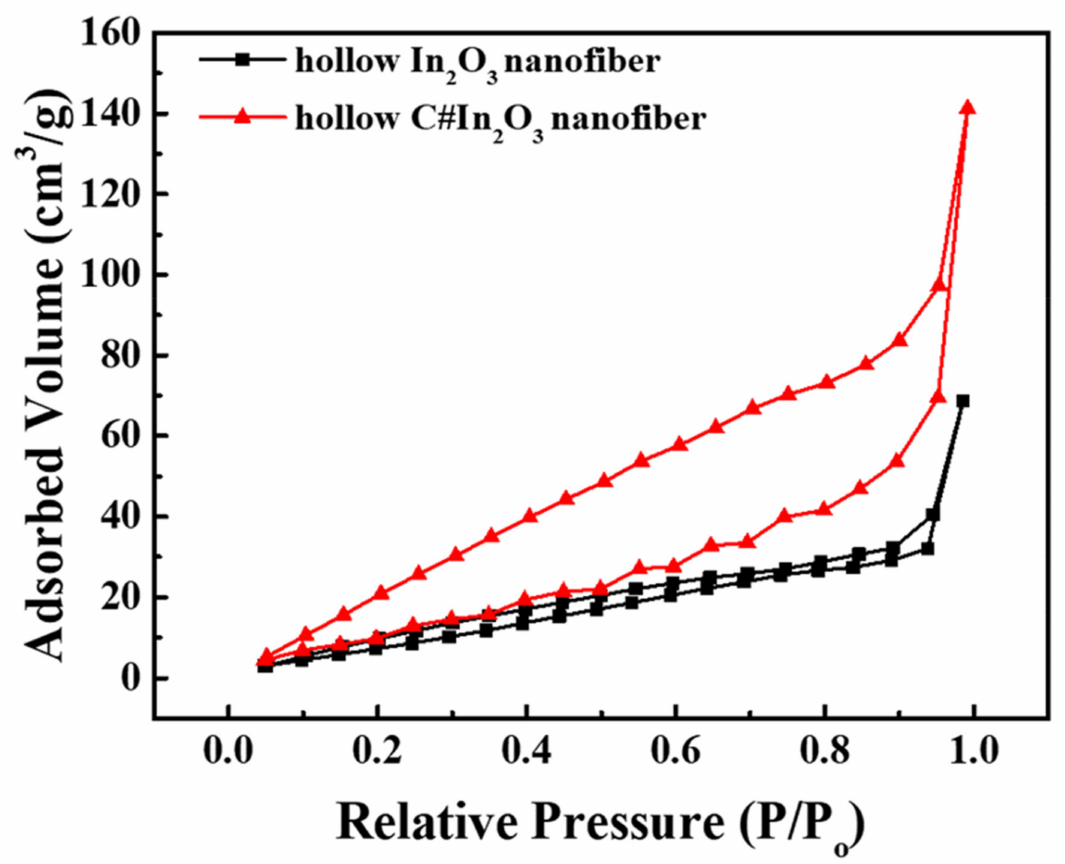
Figure 3. The BET curves of hollow In 2 O 3 and C#In 2 O 3